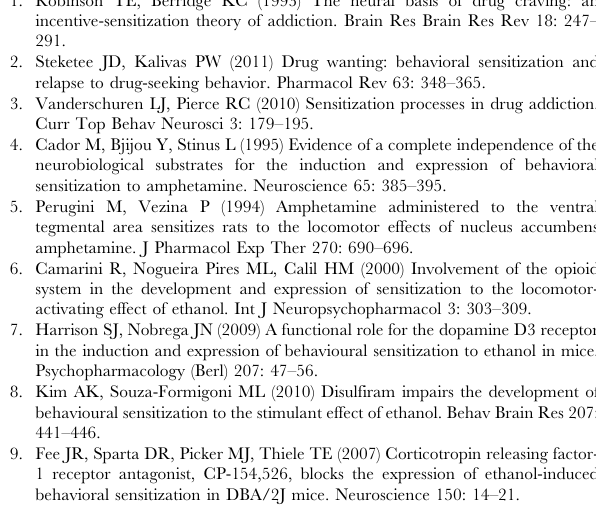
Figure S2 Expression of EIBS is not due to ethanol metabolism or food intake alteration. During 10 days, mice received daily i.p. injections of saline or ethanol (2 g/kg) solution.